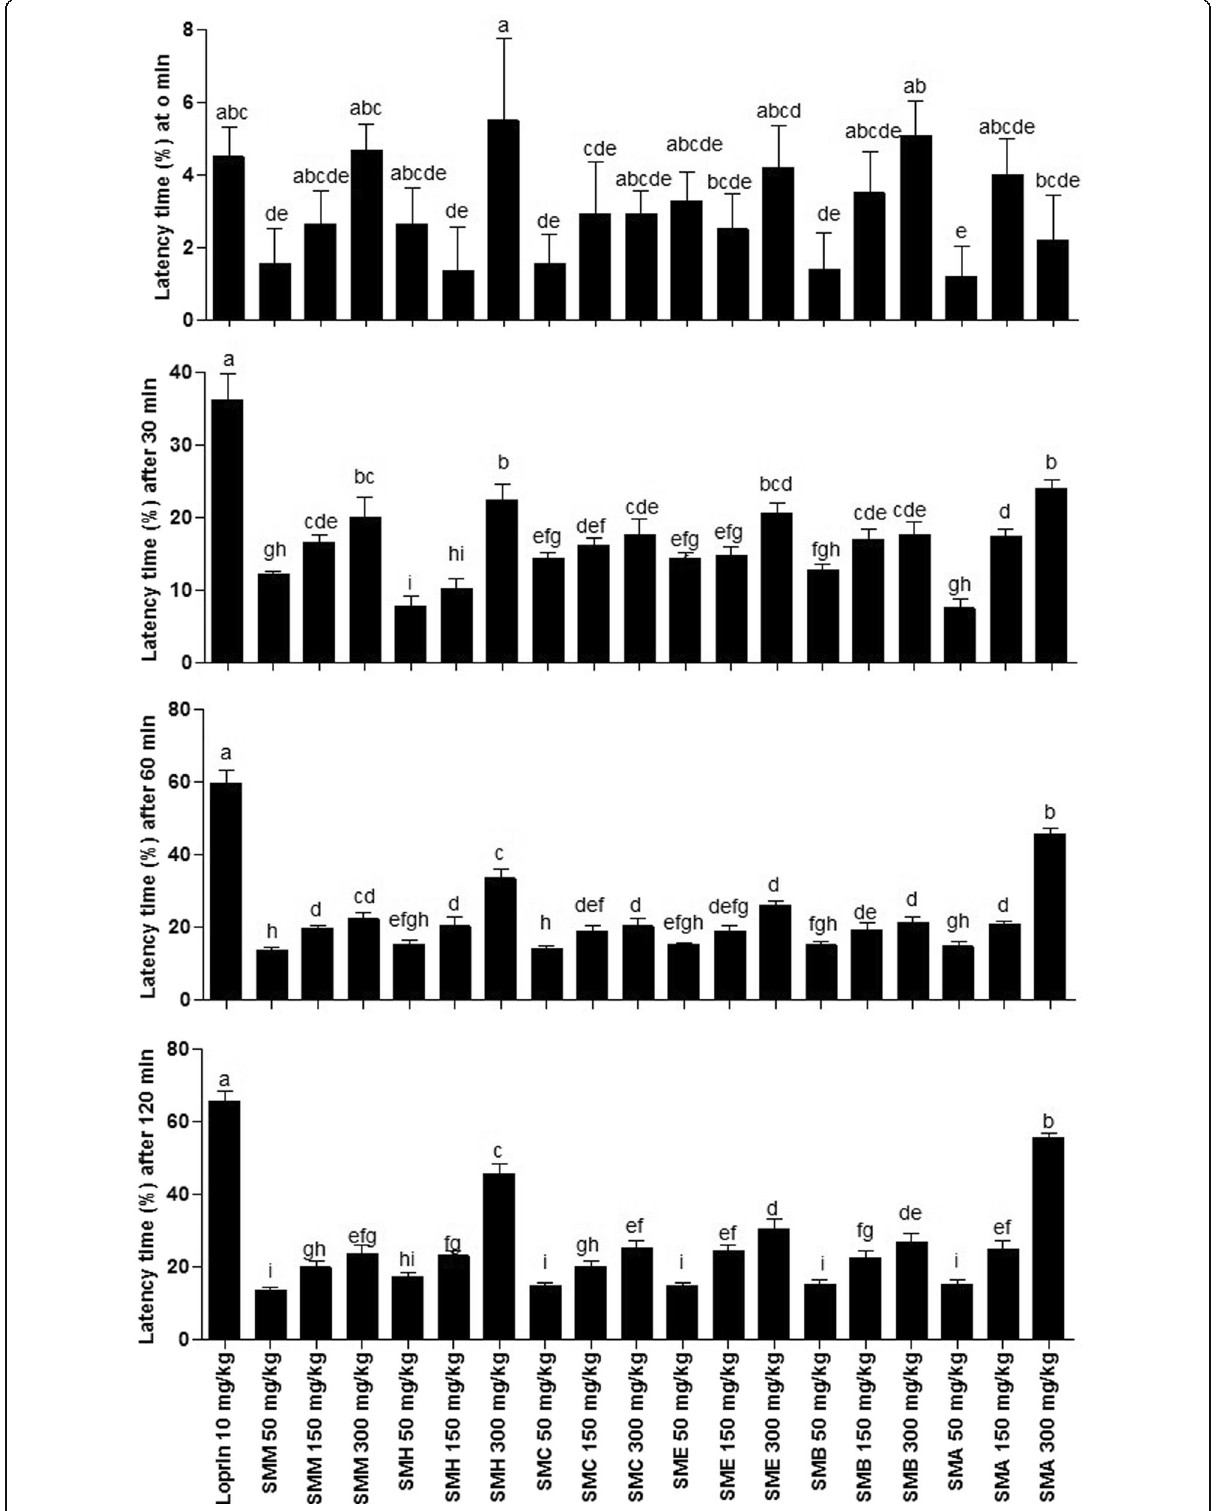
Fig. 5 Percent analgesia induced with different extract/fractions of S. mukorossi in rat. Each bar represents as Mean ± SD (n = 3). Superscript ( a-j ) indicate significance at P < 0.01. SMM, S. mukorossi methanol extract of stem bark; SMH, n-hexane fraction of SMM; SMC, chloroform fraction of SMM; SME, ethyl acetate fraction of SMM; SMA, soluble residual aqueous fraction of